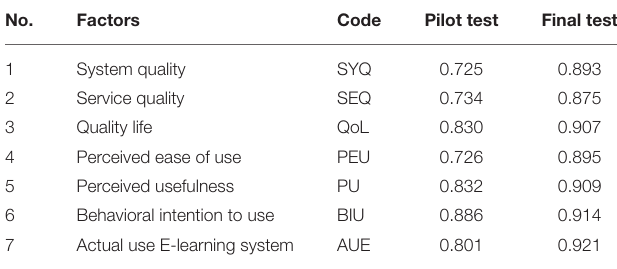
TABLE 1 | Reliability test (pilot and